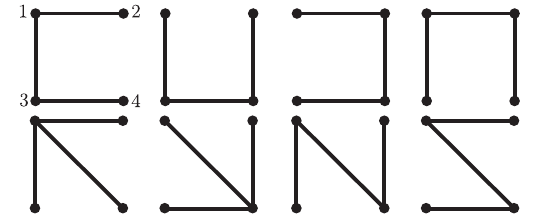
FIG. 7. Spanning trees. All spanning trees for our four-state illustrative graph.